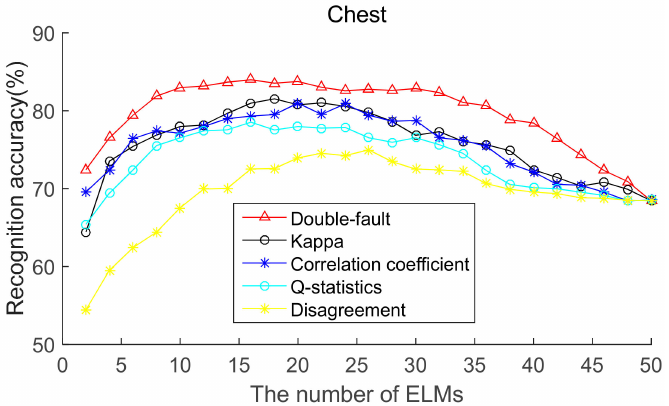
Figure 7. Recognition accuracy from chest position for ordered bagging according to five pairwise diversity measures.